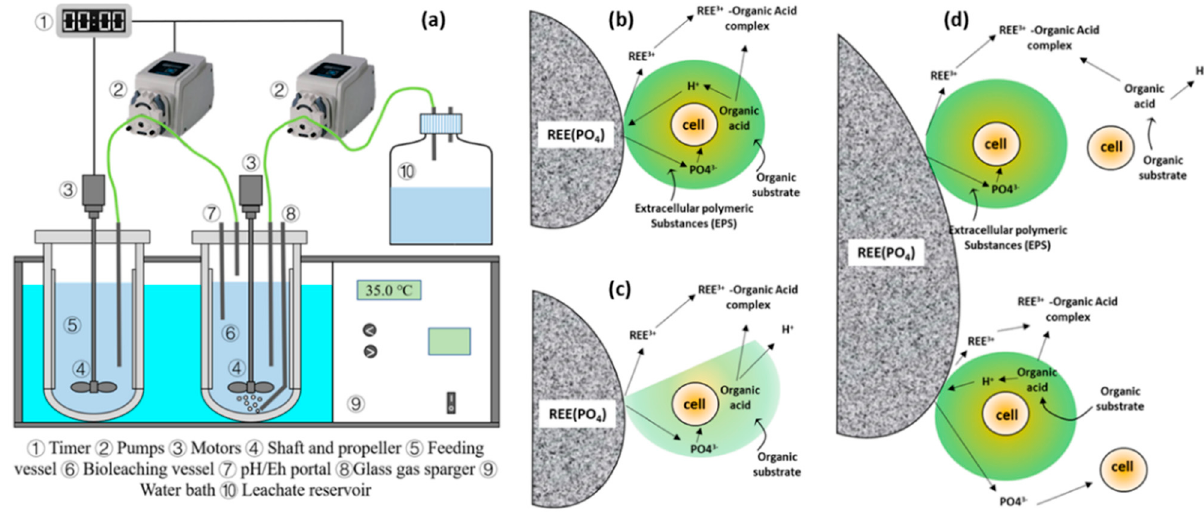
Figure 1. ( a ) Schematic diagram of the bioreactor; ( b – d ) an alternative (nonpyrite based) organic acid derived dissolution mechanism described by Fathollahzadeh et al. [12] for a typical REE mineral in presence of bioleaching microorganisms.